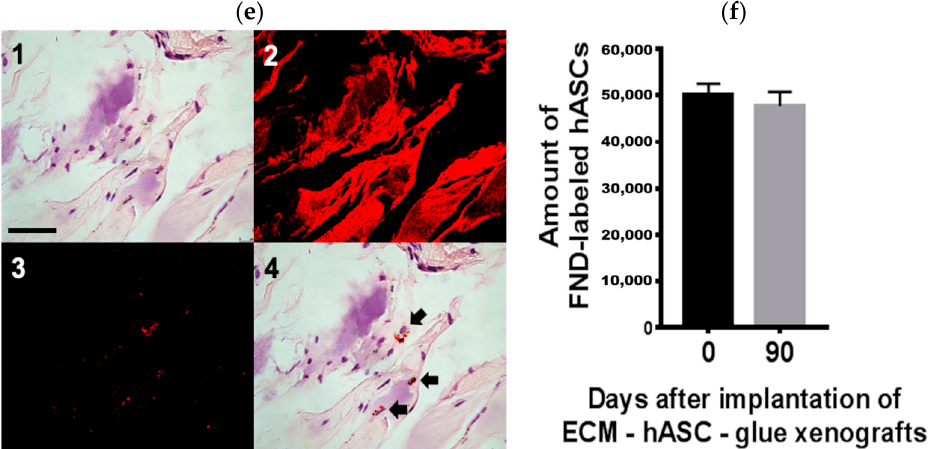
Figure 4. The xenografts composed of diced decellularized cartilage ECM and fibrin glue polymer with or without FND-labeled hASCs were transplanted subcutaneously into nude mice for three months. ( a ) Macroscopic appearance of xenografts containing ECM and fibrin glue polymer with or without FND-labeled hASCs before implantation (above) and three months afterwards (below). ( b ) Volume of the xenografts were measured. There was a statistic significant difference in the volume of xenograft between the groups of ECM-glue and ECM-hASC-glue. The values were means ± S.D. (n = 8). ** p < 0.01 versus control. Data were assessed using T tests for analysis. ( c ) Histological analysis of xenografts in both groups. Comparison of cell density by DAPI between groups of ECM-glue and ECM-hASC-glue three months afterwards (Original magnification × 400). ( d ) Cell numbers were quantified under microscope per field, as described in the Materials and Methods section, by Image J software. The ECM-hASC-glue group has significantly increased cell numbers compared to the ECM-glue group. The values were mean ± S.E.M. (n = 8). ** p < 0.01 versus control. * p < 0.05 versus control. Data were assessed using T tests for analysis. ( e ) Identification of FND-labeled hASCs in a xenograft tissue section by confocal microscopy: (1) H&E staining image, (2) confocal fluorescent image without time gating, (3) time-gated confocal fluorescent image, and (4) merged image of (1) and (3). Black arrows denote FND-labeled hASCs. Scale bar: 50 µ m. ( f ) Quantitative detection of FND-labeled hASCs with MMF. The corresponding percentages of FND-labeled hASCs found in the implanted xenografts 90 days later. The values were means ± S.E.M. (n = 3). Data were assessed using T tests for